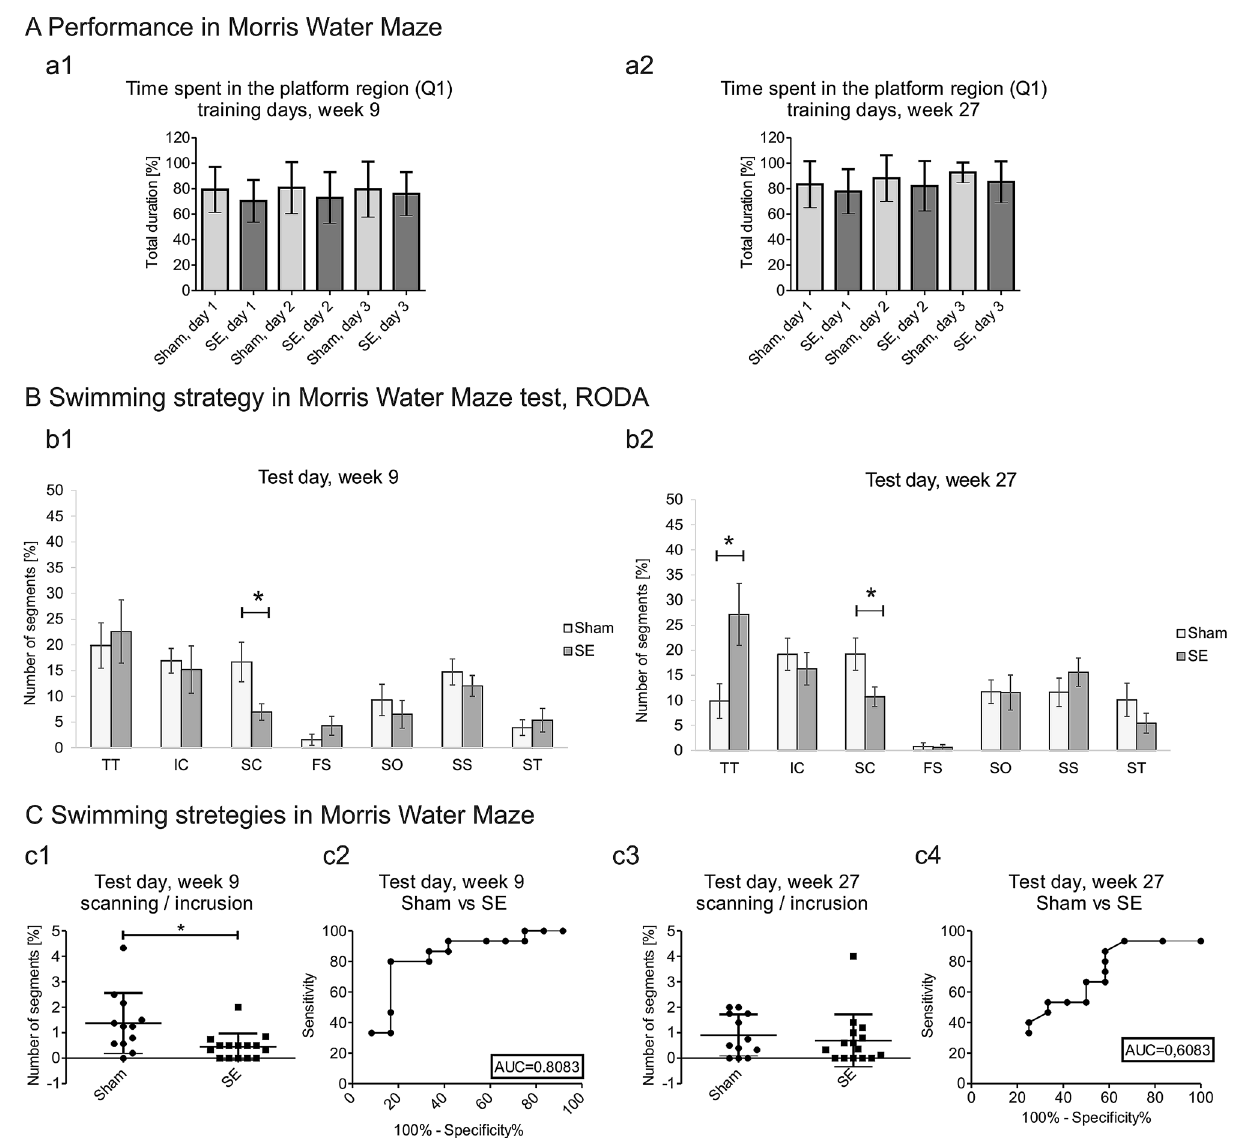
9 ( a 1) and week 27 ( a 2) (mean ± SD). ( B ) Analysis of swimming strategy in the Morris water maze on the test day using RODA software. The stimulated group (SE, n = 15) exhibited a decrease in the number of sections where they exhibited incursion (IC) and scanning (SC) strategies at weeks 9 and 27 of the experiment compared with sham animals ( n = 12) ( b 1, b 2). * p < 0.05. The focused search (FS) strategy increased at week 9, and thigmotaxis (TT) increased at week 27 in stimulated animals (SE, n = 15) compared with sham animals ( n = 12). * p < 0.05 (mean ± SEM). ( C ) Comparison of scanning and incursion strategies in the Morris water maze. A lower proportion of scanning (SC) to incursion (IC) was observed in stimulated rats (SE, n = 15) compared with the sham group ( n = 12) on the test day at week 9. * p < 0.05 ( c 1, c 2). No differences were observed at week 27 (c3-c4) (mean ±